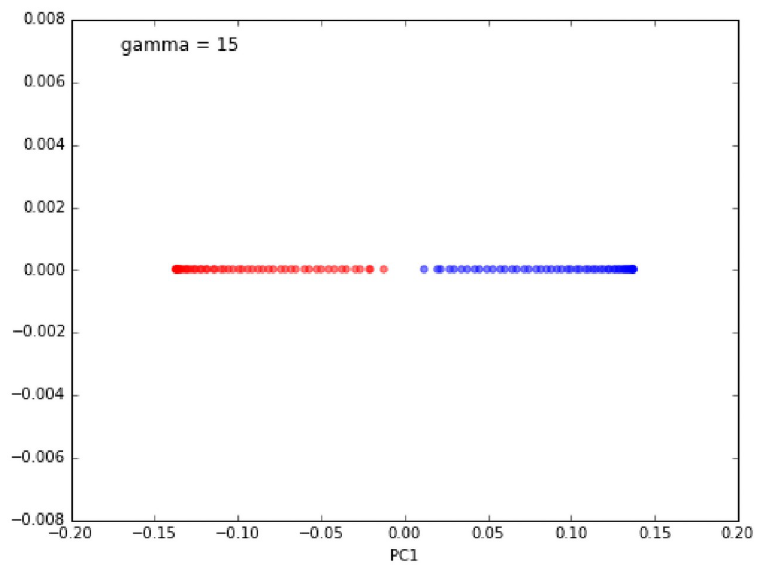
Fig 26. Kernel PCA result [69].